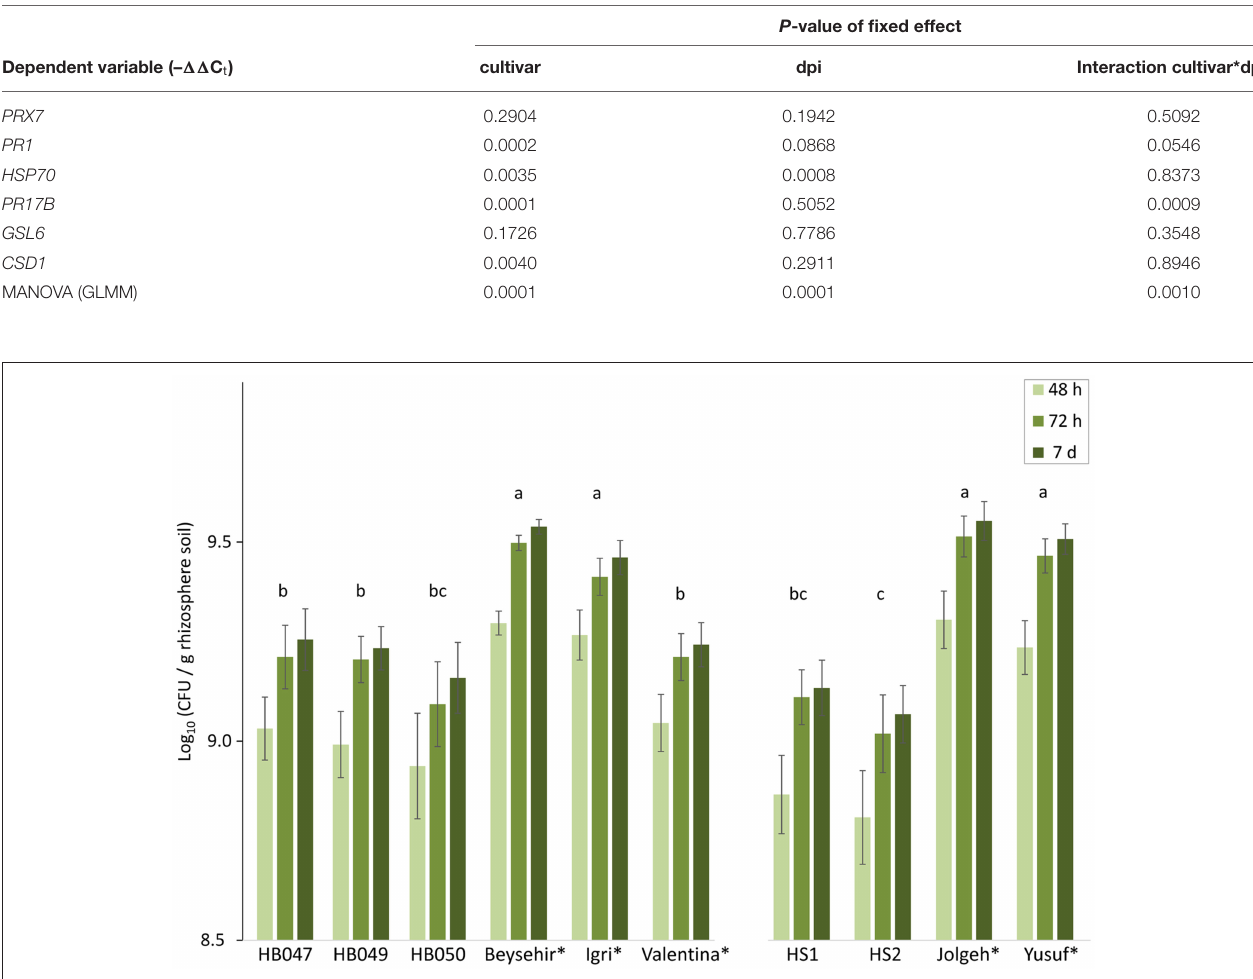
FIGURE 3 | Microbial density in the rhizosphere of elite cultivars (indicated by a star) and ancestral genotypes of barley 4 weeks after inoculation of a soil microbiome to the roots. Colony-forming units (CFU) on R2A plates were counted after 2, 3, and 7 days incubation at 28 ◦ C. Mean log-transformed CFU/g from the two independent experiments are separated on the horizontal axis. Error bars indicate SE ( n = 6 rhizosphere samples per genotype of barley; each sample was derived from two plants). The same letter above triples of bars indicates not significant differences between genotypes (generalized linear mixed model, repeated measures, and Tukey’s